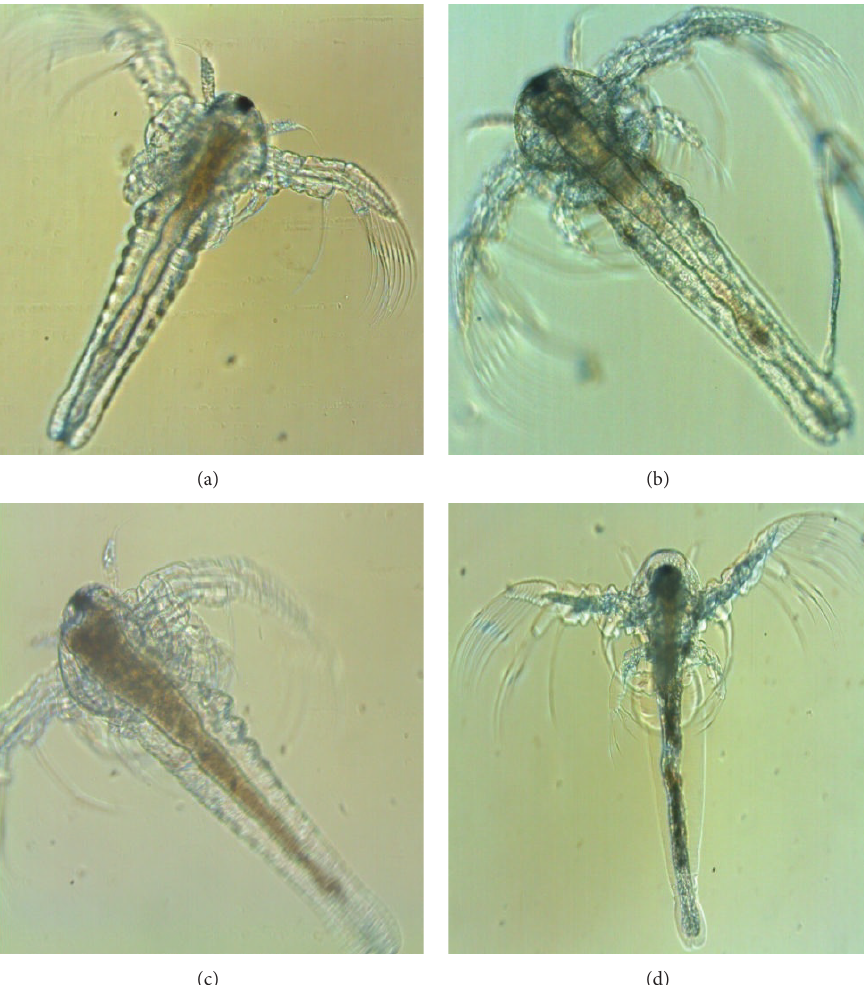
Figure 5: Morphological variations of Artemia nauplii treated with silver nanoparticle observed using inverted phase contrast microscope (20x magnification): control (a), 2nM concentration of AgNPs (b), LC 50 concentration (10nM) of AgNPs (c), and 12nM concentration of AgNPs